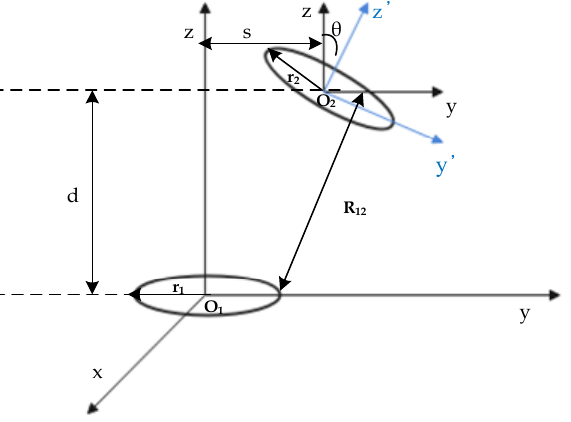
Figure 2. Configuration of the special WPT coils with lateral and angular misalignment.